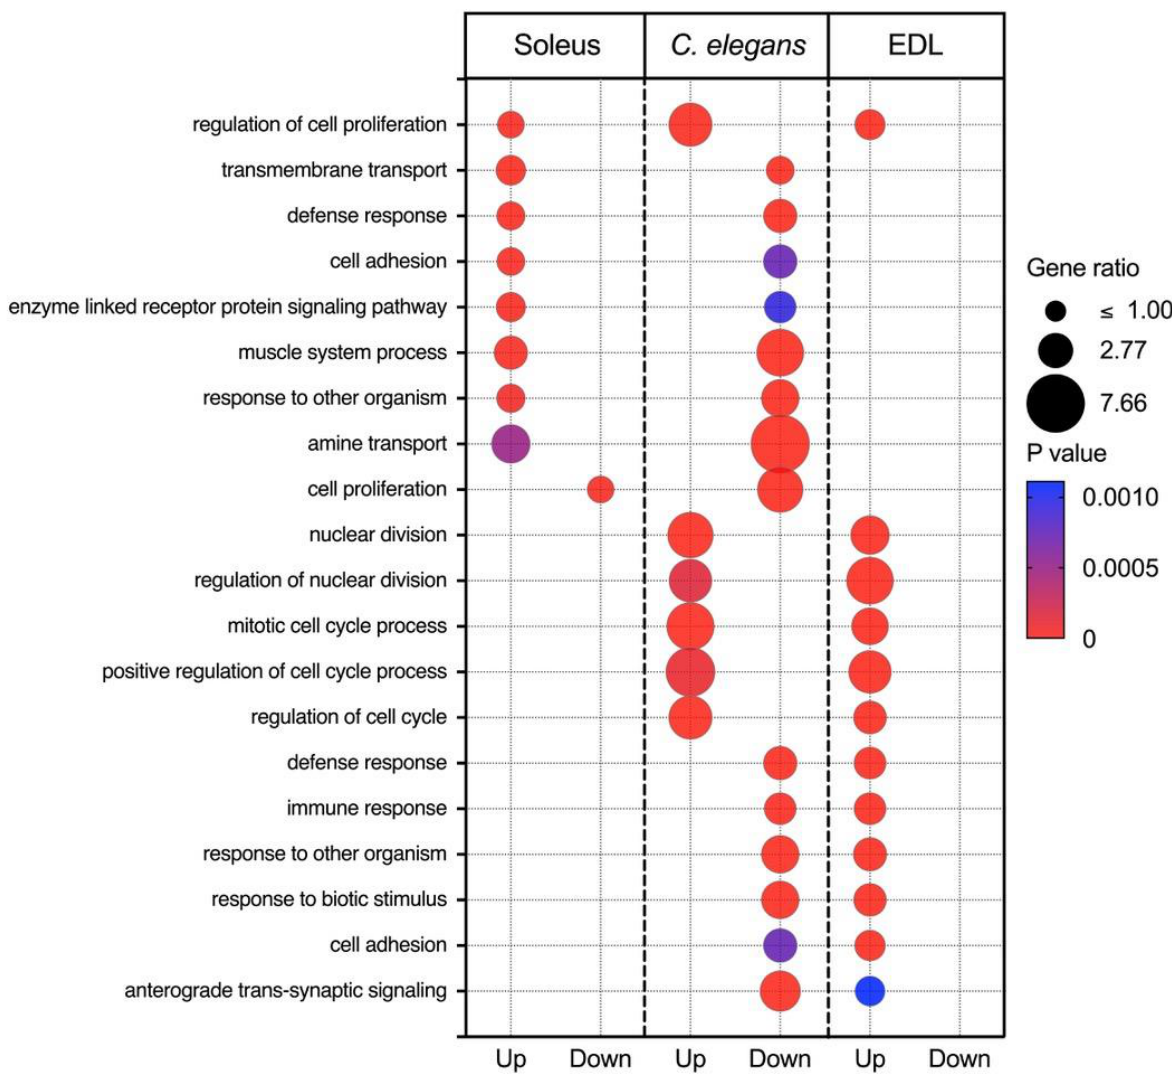
Figure 3. Shared upregulated and downregulated biological processes in C. elegans compared with soleus and the EDL in response to spaceflight. The resulting gene ratio and P values from Webgestalt analysis of DEGs are shown.